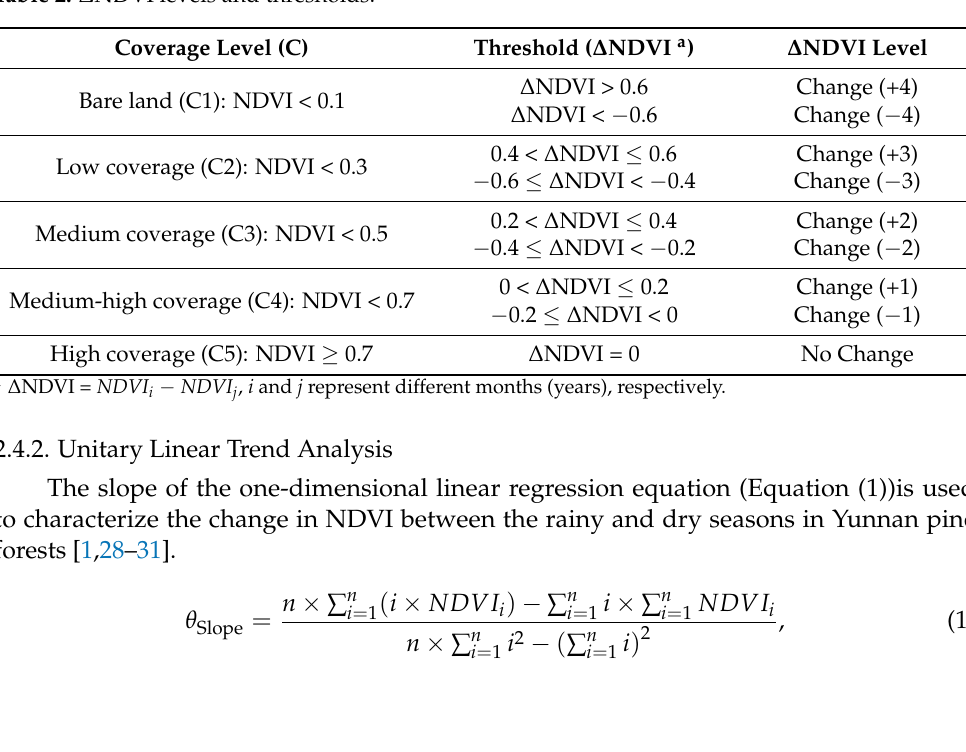
Table 2. ∆ NDVI levels and